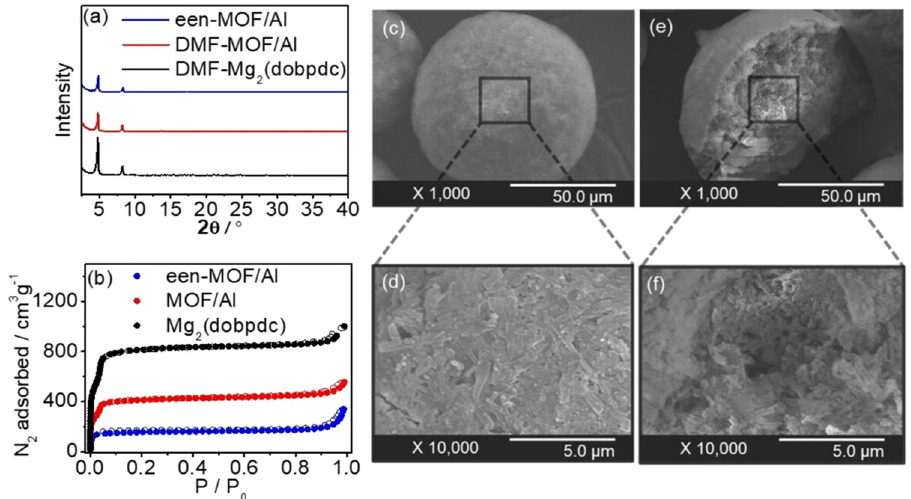
Fig. 2 Characterizations of MOF/Al microbeads and diamine-grafted MOF/Al microbeads. a PXRD data of DMF – MOF, DMF – MOF/Al, and een – MOF/ Al. b N 2 isotherms for Mg 2 (dobpdc), MOF/Al, and een – MOF/Al at 77 K. c SEM image of the surface of DMF – MOF/Al. d Enlarged SEM image of the surface of DMF – MOF/Al. e SEM image of the inside of MOF-MOF/Al. f Enlarged SEM image of the inside of DMF –